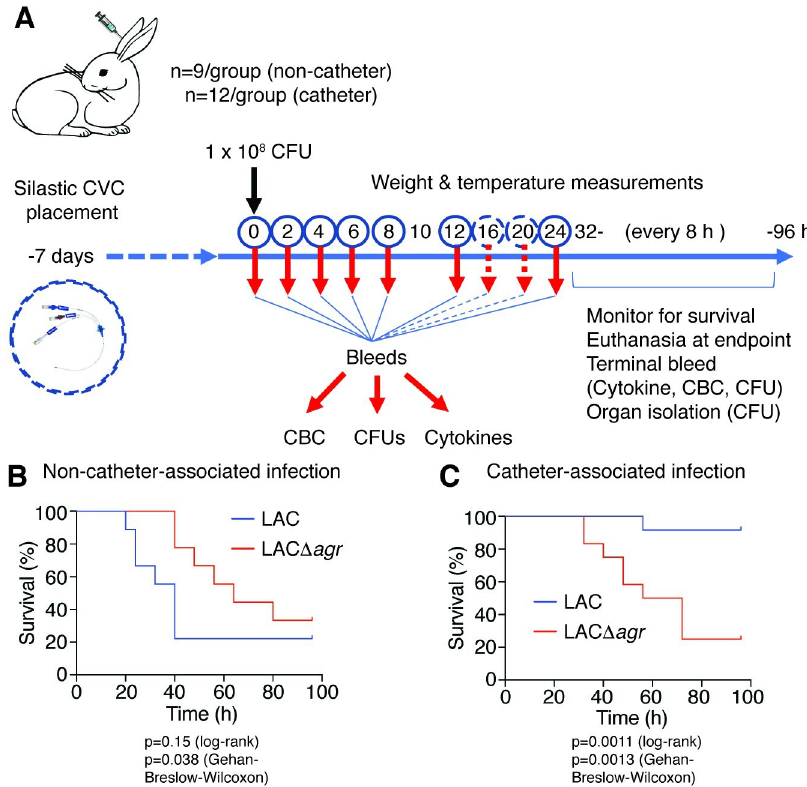
Fig 2. Rabbit sepsis models–experimental setup and survival. ( A ) Experimental setup of catheter- and non-catheter- associated model. The models were set up essentially in the same fashion, except that in the catheter-associated model, a silastic CVC was inserted 7 days before injection of 10 8 CFU of S . aureus LAC or its isogenic Δ agr deletion strain and additional 16- and 20- h samples (dashed circles) were only taken in the catheter-associated model. (B ) Survival curve in the non-catheter associated (n = 9/group) and ( C ) of the catheter-associated model (n = 12/group). The non- catheter-associated model was performed two independent times (n = 4/group and n = 5/group, respectively; total, n = 9 animal/group). The catheter-associated model was performed two independent times with n = 6 animals/group each (total, n = 12 animals/group). Data obtained with the two batches were combined in both models. Statistical analysis is by the indicated tests. Rabbit picture is from